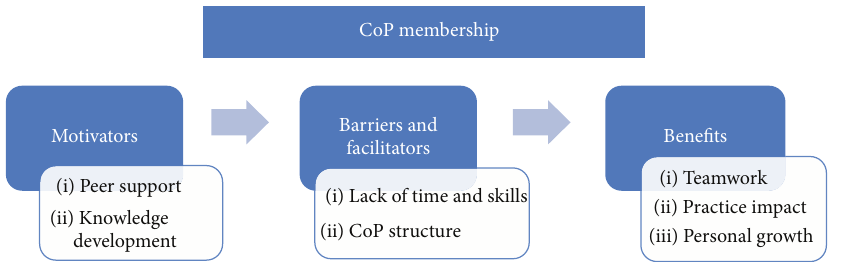
Figure 1: Themes identified from the